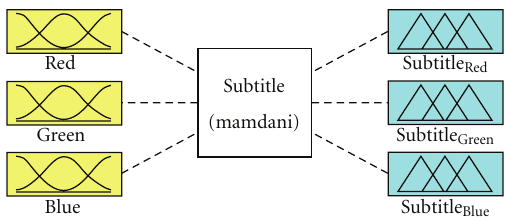
Figure 4: The block diagram of subtitle fuzzy analyzer.